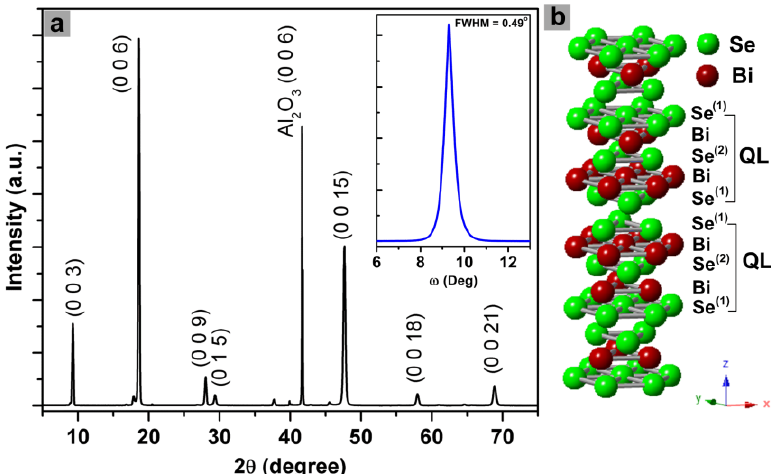
Figure 1. ( a ) X-ray diffraction (XRD) patterns of a bismuth selenide (Bi 2 Se 3 ) thin film grown on c -plane sapphire using pulsed laser deposition (PLD). The inset in (a) shows the XRD rocking curve of (006) peak for the film. ( b ) Crystal structure of Bi 2 Se 3 (QL is quintuple layer).